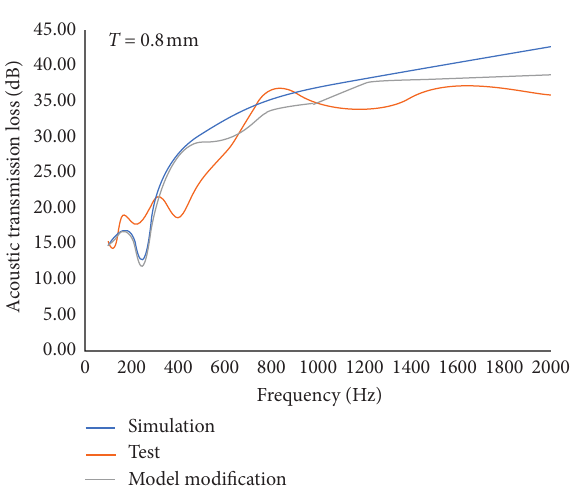
Figure 8: Validation of the front coaming model with a thickness of